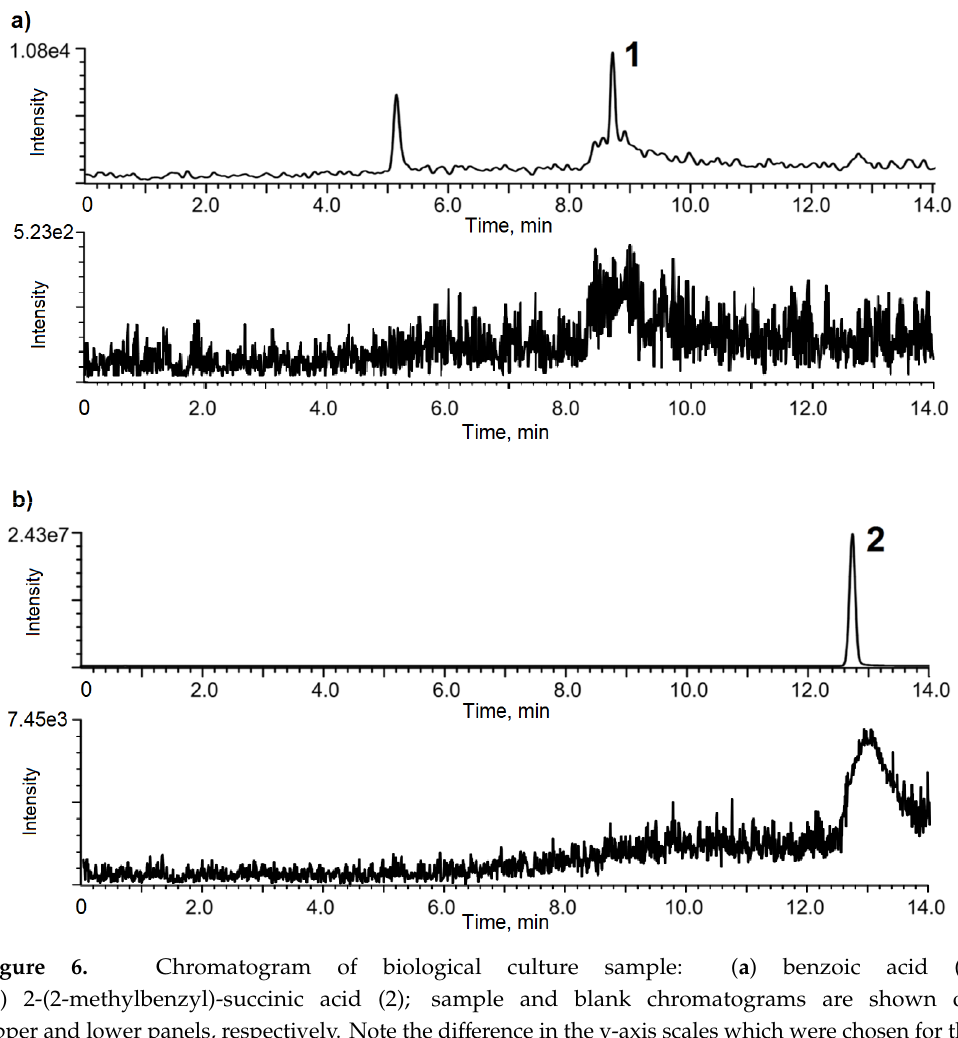
Figure 6. Chromatogram of biological culture sample: ( a ) benzoic acid (1) ( b ) 2-(2-methylbenzyl)-succinic acid (2); sample and blank chromatograms are shown on upper and lower panels, respectively. Note the difference in the y-axis scales which were chosen for the maximum zoom of the chromatogram.